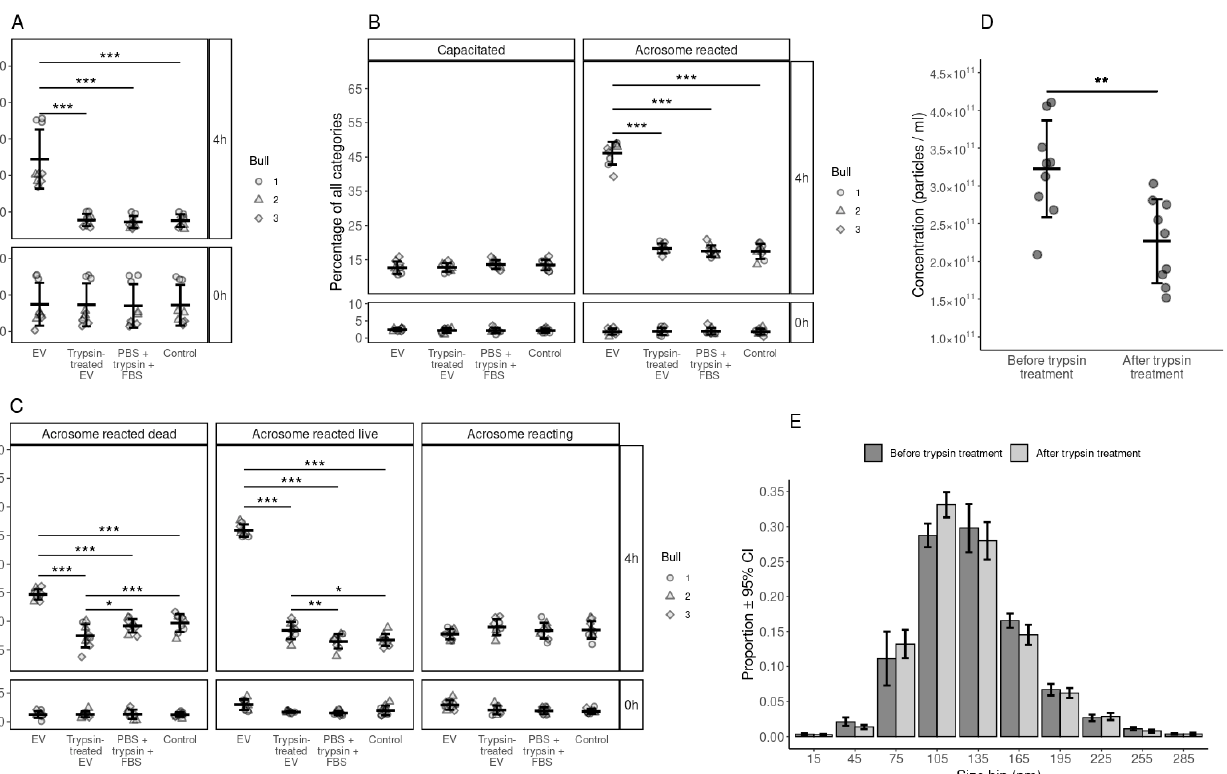
Figure 5. Analysis of functional aspects of bovine spermatozoa by incubating them with trypsin treated EVs, non treated EVs and PBS+trypsin+FBS and control. ( A ) Percentage of live spermatozoa at 0 and 4 hours after supplementation with treated and non treated EVs, FBS+trypsin+PBS and Control group. ( B ) Percentage spermatozoa in different stages of capacitation reaction at 0 and 4 hours after supplementation with treated and non treated EVs, FBS+trypsin+PBS and Control group. ( C ) The percentages of spermatozoa in different stages of the acrosomal reaction at 0 and 4 hours after supplementation with treated and non treated EVs, FBS+trypsin+PBS and Control group. ( D ) The concentration of nanoparticles in the EV samples before and after trypsin treatment. ( E ) Size profile of nanoparticles in the EV samples before and after trypsin treatment. Error bars represent 95% confidence intervals (CI). With the exception of subfigure E, error bars display the mean ± standard deviation (SD). Different symbols represent measurements of samples from different bulls, where applicable. Asterisks mark statistically significant differences and relate to p-values as follows: * p ≤ 0.05; ** p ≤ 0.01; *** p ≤ 0.001.